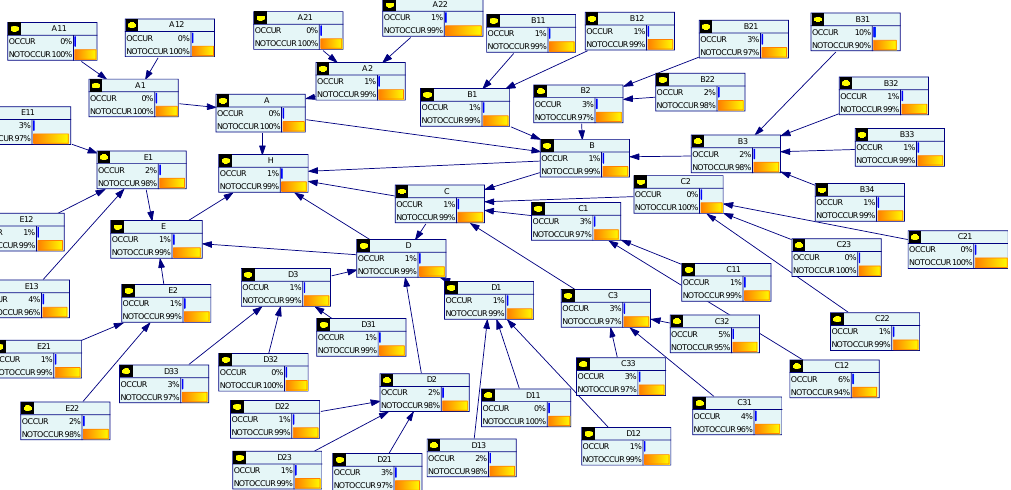
Figure 5. BN forward reasoning of safety accidents in hoisting construction of prefabricated